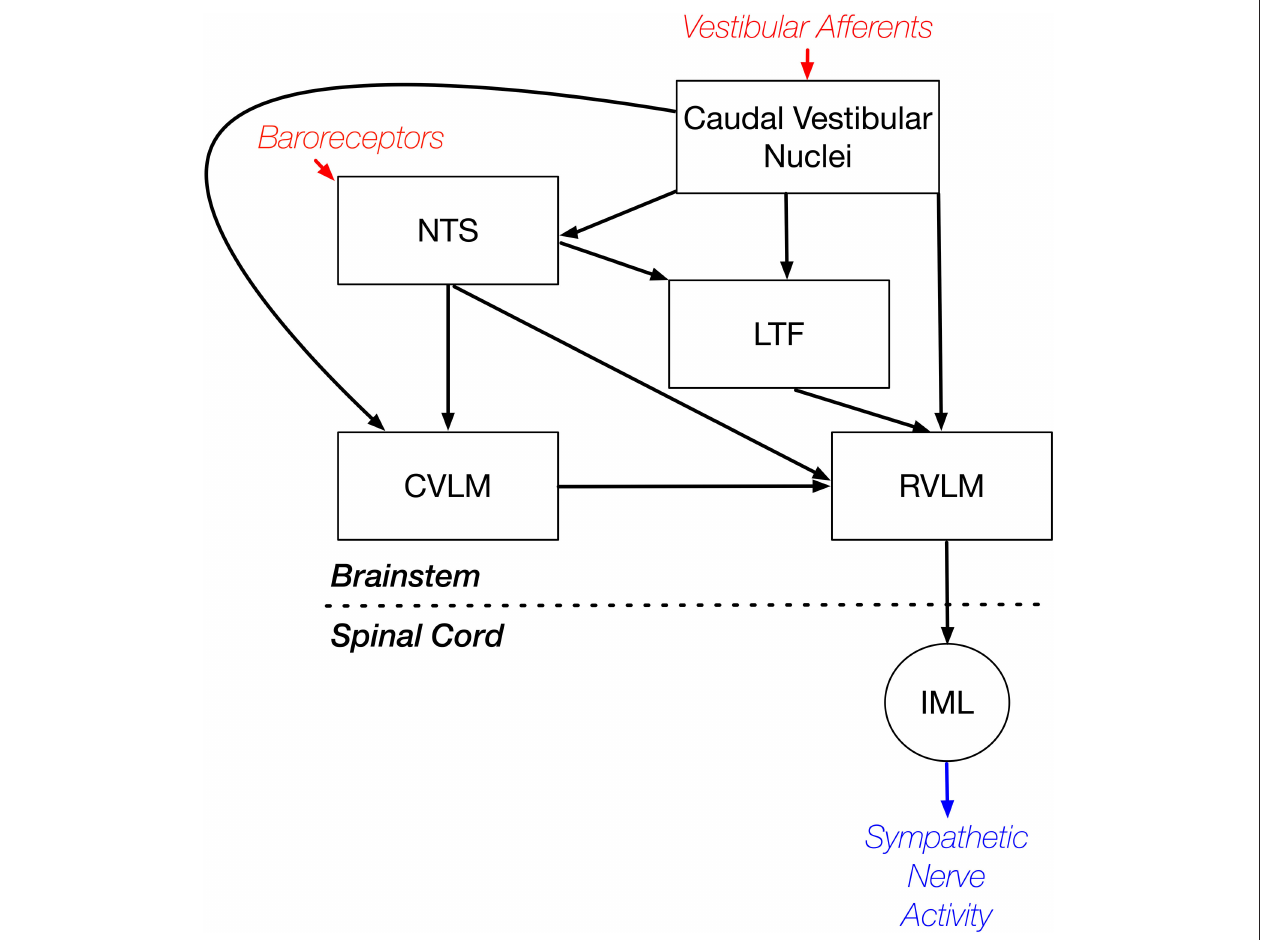
FIGURE 10 | Brainstem regions that relay vestibular signals to the RVLM. This neural circuit diagram is based on the findings of both anatomical (18–21, 39–42) and electrophysiologic (21, 43) studies that mapped connections in the vestibulo-sympathetic pathway. Red text and arrows indicate afferent inputs, and blue text and arrows denote efferent (output) pathways from the central nervous system. CVLM, caudal ventrolateral medulla; IML, sympathetic intermediolateral cell column; LTF, lateral tegmental field; NTS, nucleus tractus solitarius; RVLM, rostral ventrolateral medulla.